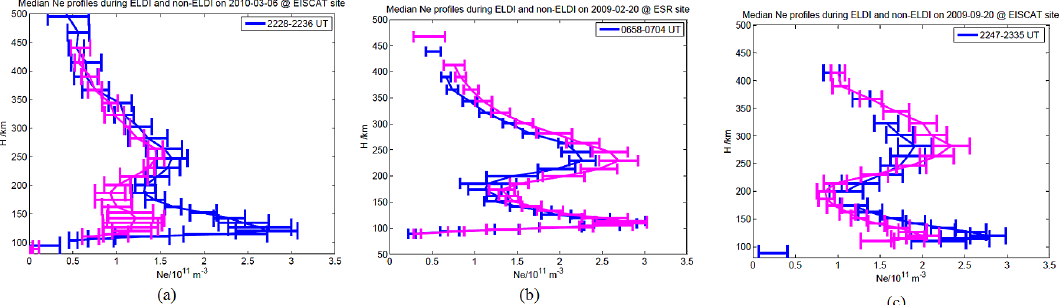
Figure 9. Electron density median profiles (blue lines) observed by EISCAT/ESR radars during the presence of three types of ELDIs. Ne profiles around presence of the ELDI (magenta lines) are superposed for reference. The standard deviations of these profiles are presented as error bars.